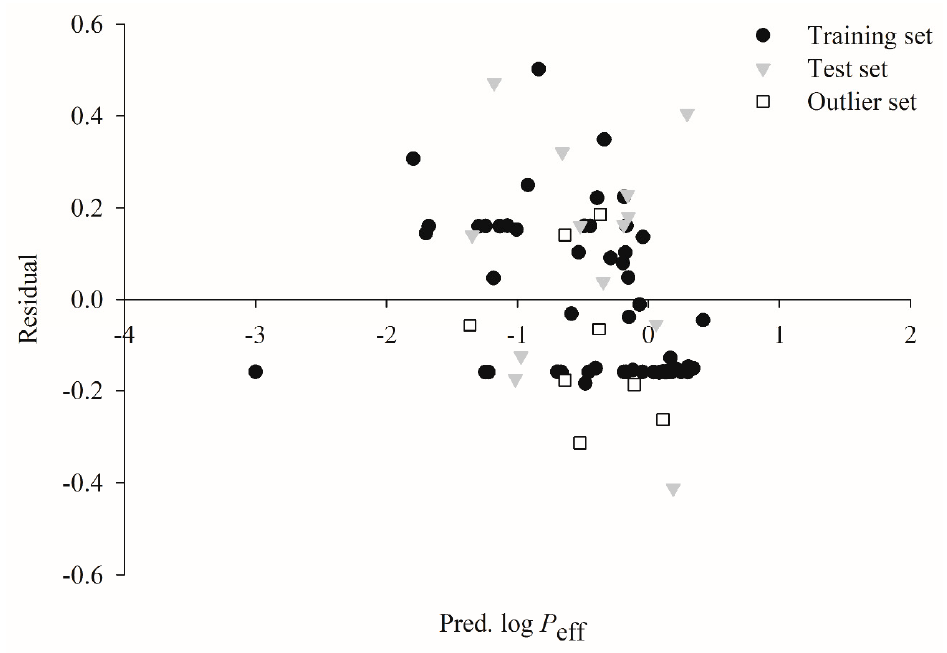
Figure 5. Residual vs. the log P eff predicted by HSVR in the training set (solid circle), test set (gray triangle), and outlier set (open square).